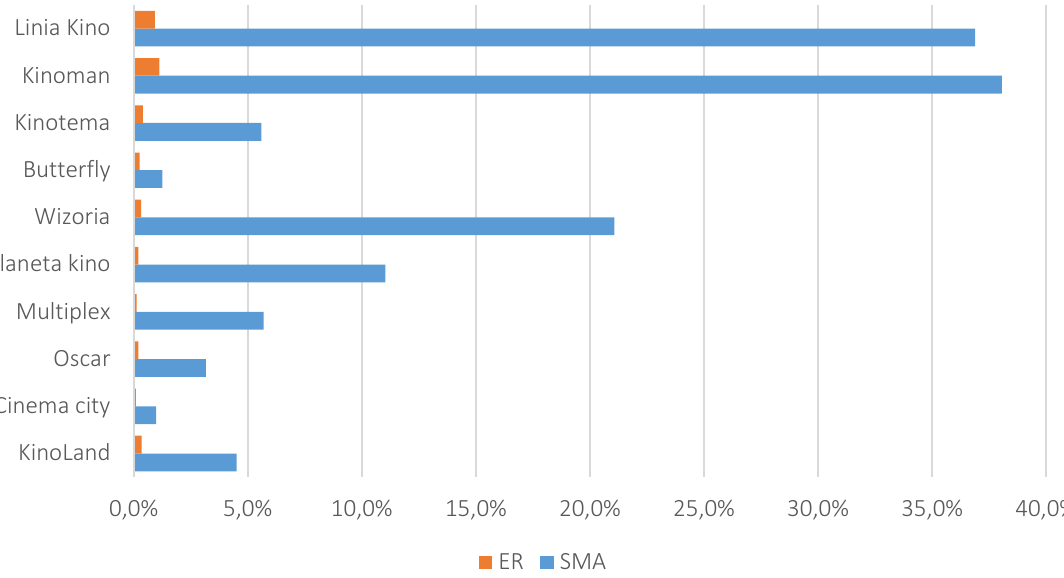
Figure 5. Activity and engagement indicators of the audience on